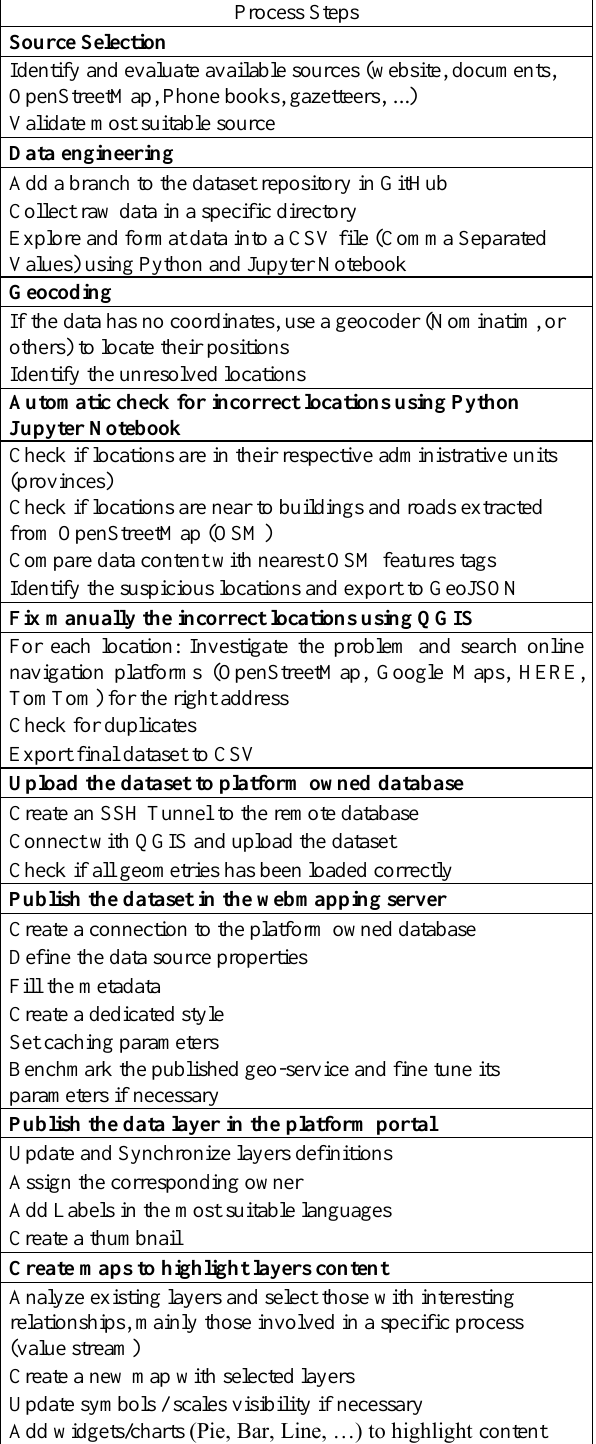
Table 3 . POIs dataset production